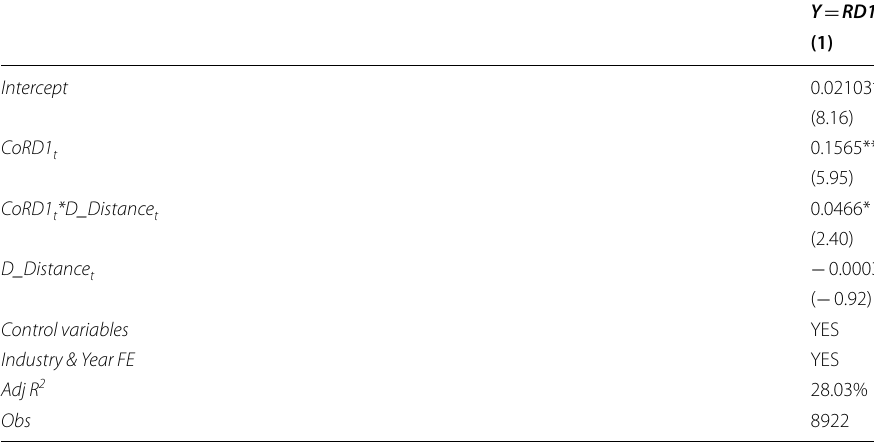
Table 7 Robustness test of